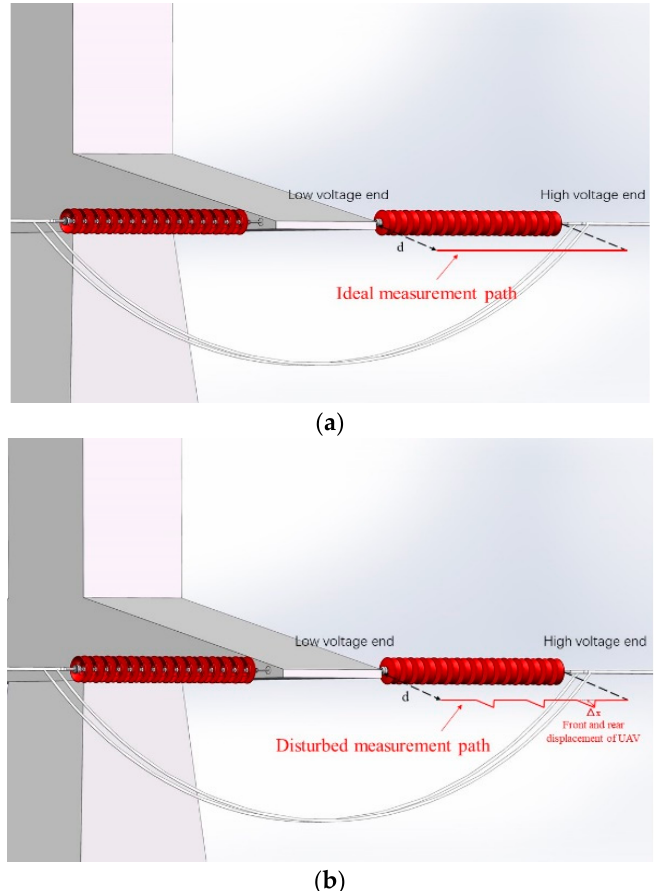
Figure 5. Schematic diagram of detecting attitude disturbances of equipment. ( a ) Ideal measurement path. ( b ) Disturbed measurement path.